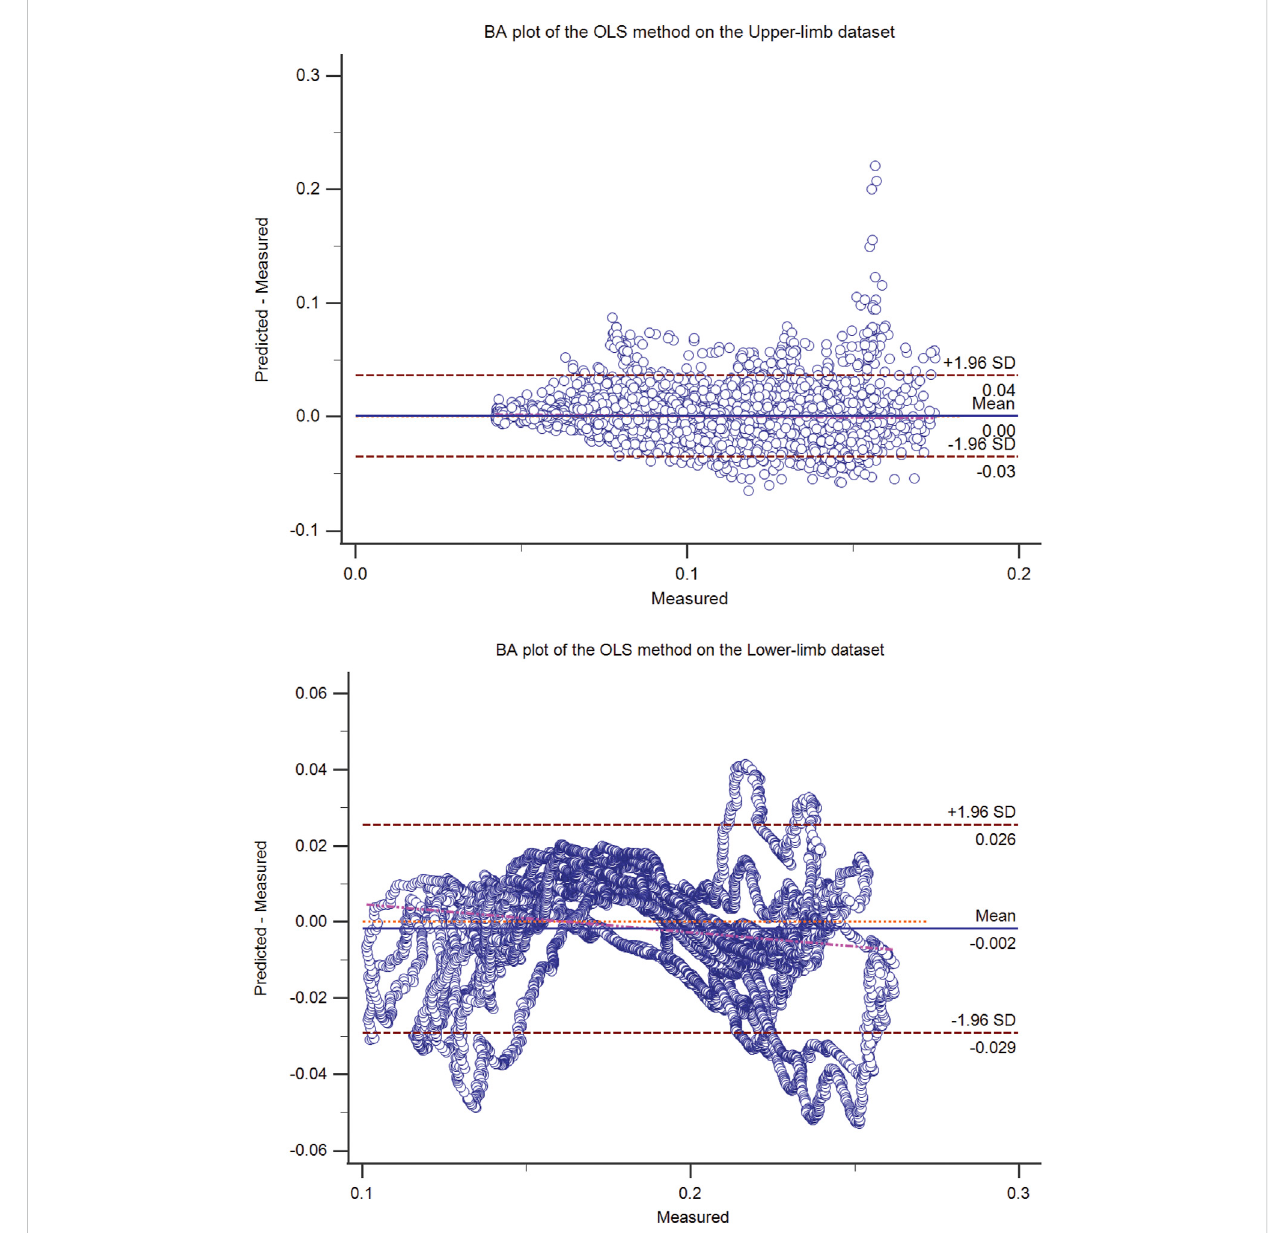
FIGURE 2 The Bland-Altman (BA) plot of the OLS method on the upper-limb (top) and the lower-limb (bottom) test dataset (50% hold-out validation). The BA plot shows the scatter plot of the residual signal (predicted force minus measured force signal) (y-axis) and the measured force signal (x-axis), which identi fi esthe homogeneity ofthe residual signal at different measured signal levels. In addition to themean residual signal (i.e., bias), the upper and lower boundaries (mean (residual signal) ± SD (residual signal)) are also